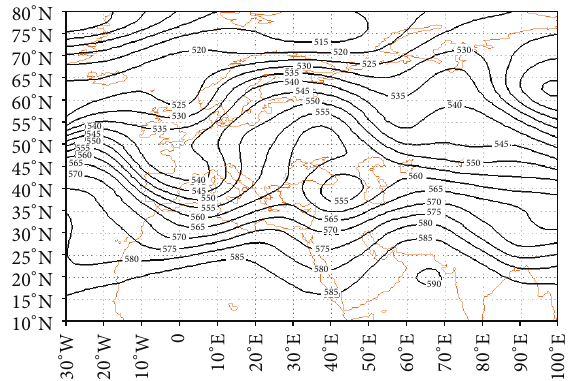
Figure 28: Geopotential elevation map at level 500 HPa in the representative day of pattern B.